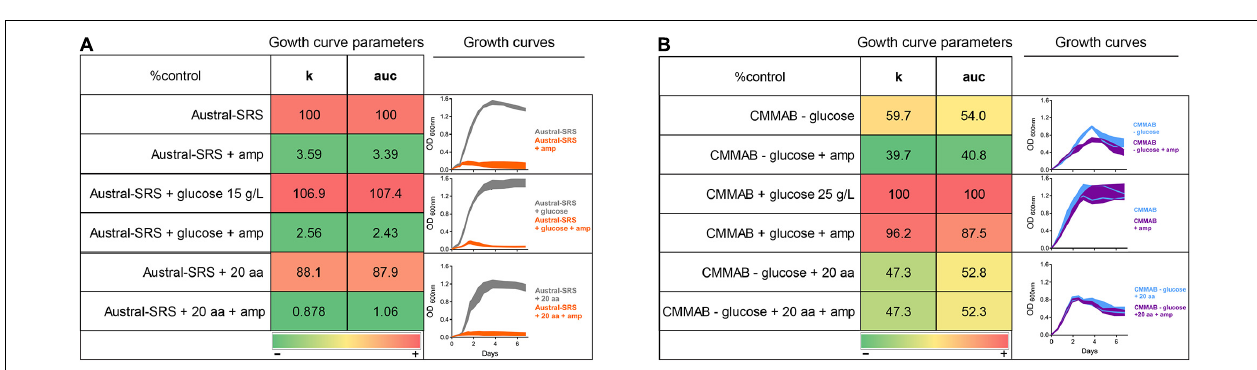
FIGURE 5 | Expression of putative amp resistance genes in P. salmonis grown in the different media. Relative transcript abundance of selected ARGs predicted to confer amp resistance in P. salmonis LF-89. Bar-graph showing transcript levels quantified by qPCR and expressed as (cid:49)(cid:49) Ct values normalized by the housekeeping genes glyA and pykA . The dotted line indicates the normalized control values ( (cid:49)(cid:49) Ct = 1). A two-way ANOVA with Tukey’s test for multiple comparisons was performed. Significantly different values are marked (*** p < 0.001 and ** p < 0.01).